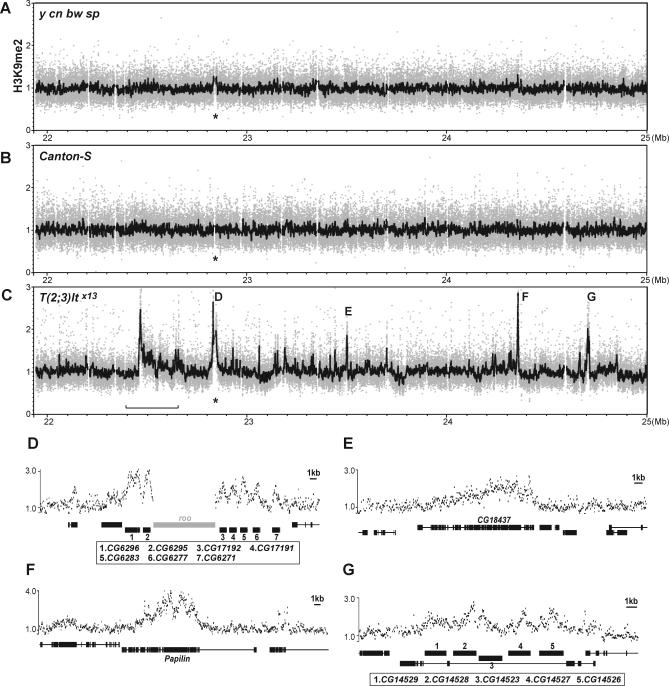
Alteration of H3K9me2 Profile by Chromosome Rearrangement(A–C) The plots show the H3K9me2-profiles for Chromosome 3R euchromatic region, which is underlined in Figure 2. This region is located distally in 3R in normal strains y; cn bw sp (A) and Canton-S (B) and displaced proximally in the rearranged chromosome T(2;3)ltx13 (C) . The bracket in (C) indicates the 97C region where the T(2;3)ltx13 breakpoint has been localized [19]. The gap in the probes marked by asterisk corresponds to the roo retrotransposon mentioned in the text.(D–G) Expanded views of T(2;3)ltx13-induced H3K9me2 peaks. Peaks at coordinates 23.5 Mb (E) and 24.3–24.4 Mb (F) coincide with a large gene with high exon density. Peaks at 22.8–22.9 Mb (D) and 24.7 Mb (G) coincide with a duplicated gene cluster. In (D), these genes are 58%–93% identical to each other at the nucleotide sequence level over an ∼1 kb stretch. In (G), CG14527 and CG14526 are 84% identical over ∼2kb. However, the other gene pairs in this cluster are highly diverged (<55% identity at the nucleotide sequence level, ∼50% similarity at the amino-acid sequence level).